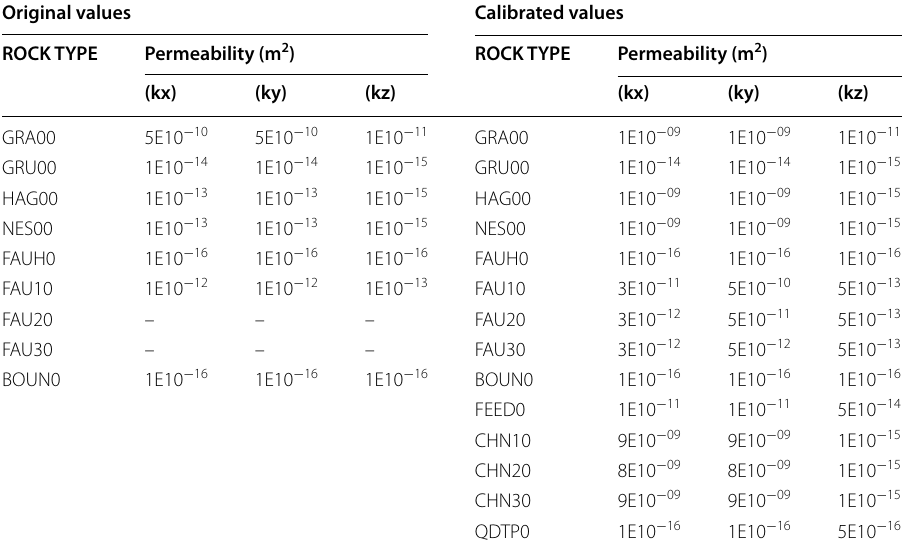
The matrix permeability used for all rock types is 1E10 − 16 m 2